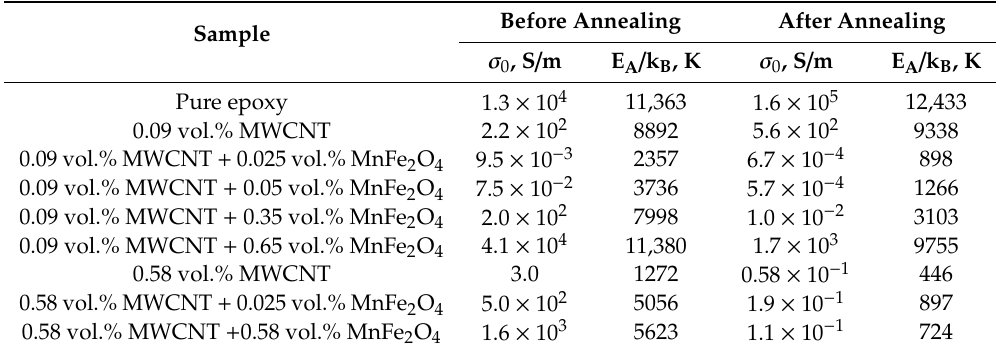
Table 1. Parameters of the Arrhenius law